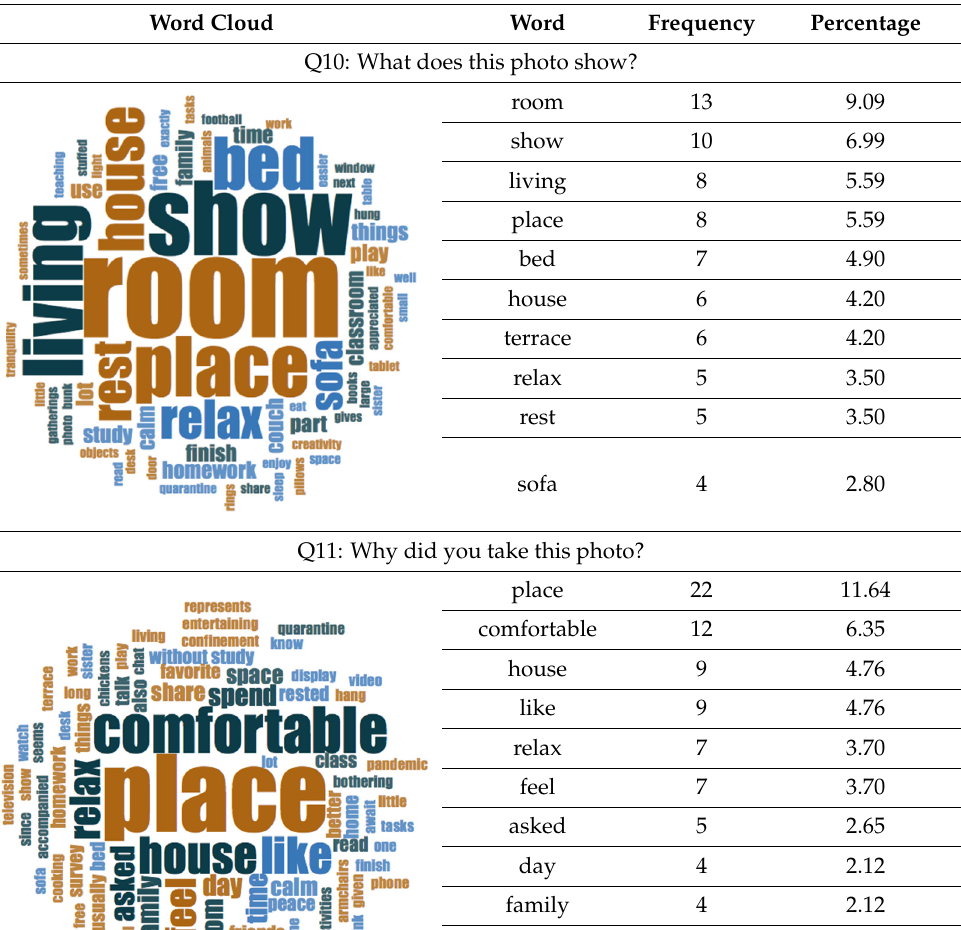
Table 5. Word clouds referred to picture-related questions on most comfortable spaces at home. Block 2: Most Comfortable Space. Word Clouds for Related Questions.